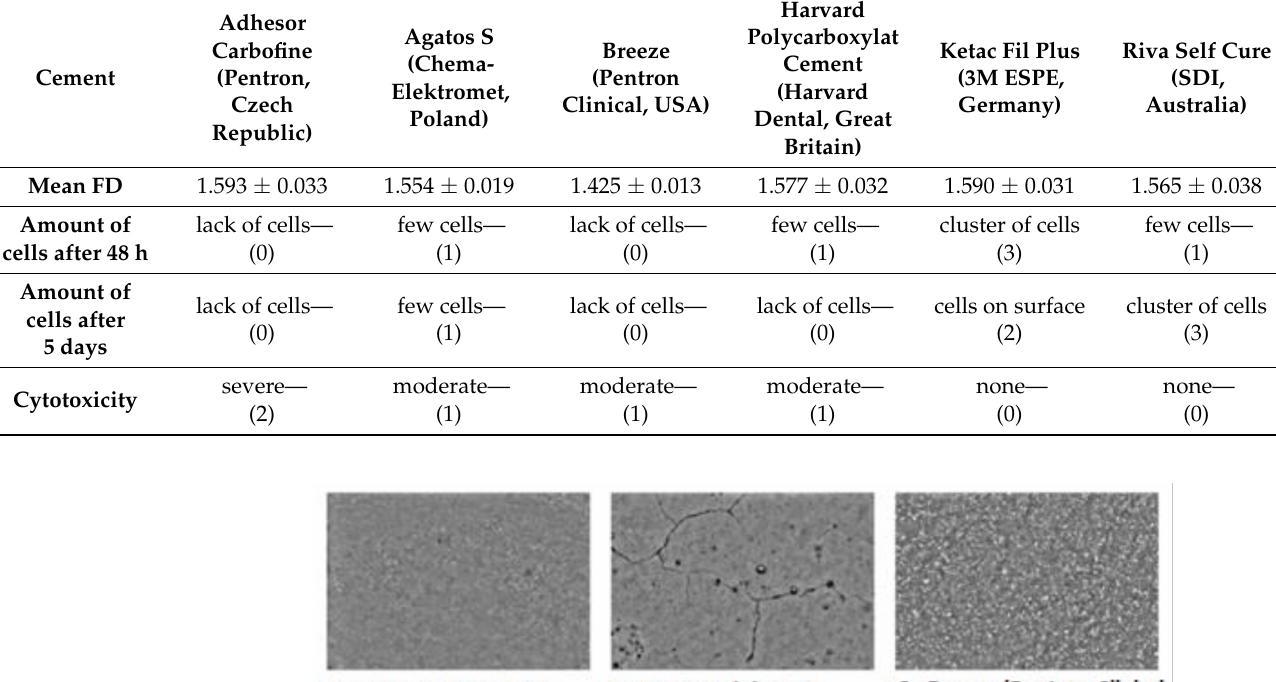
Table 1. Mean values of FD for individual cements and results of fibroblast adhesion tests after 48 h and 5 days of culture as well as evaluation of cytotoxicity of the tested cements (SD—standard deviation, FD—fractal dimension). Qualitative properties of cells were converted to quantitative parameters. For amounts of cells: lack of cells—0, few cells—1, cells on